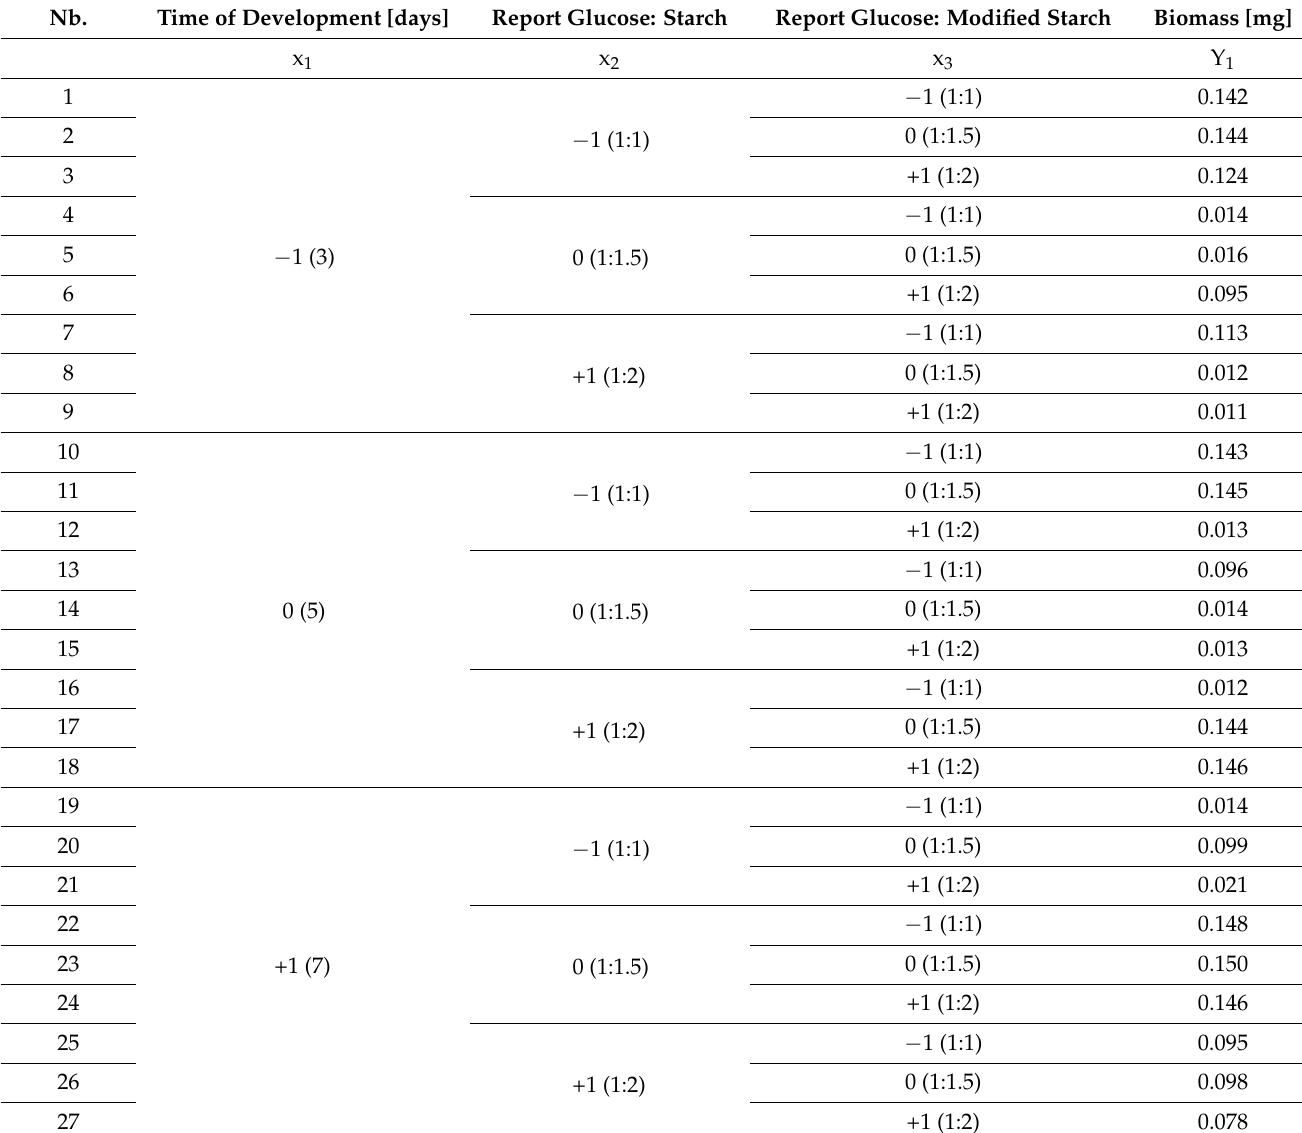
Table 3. Coefficients of the